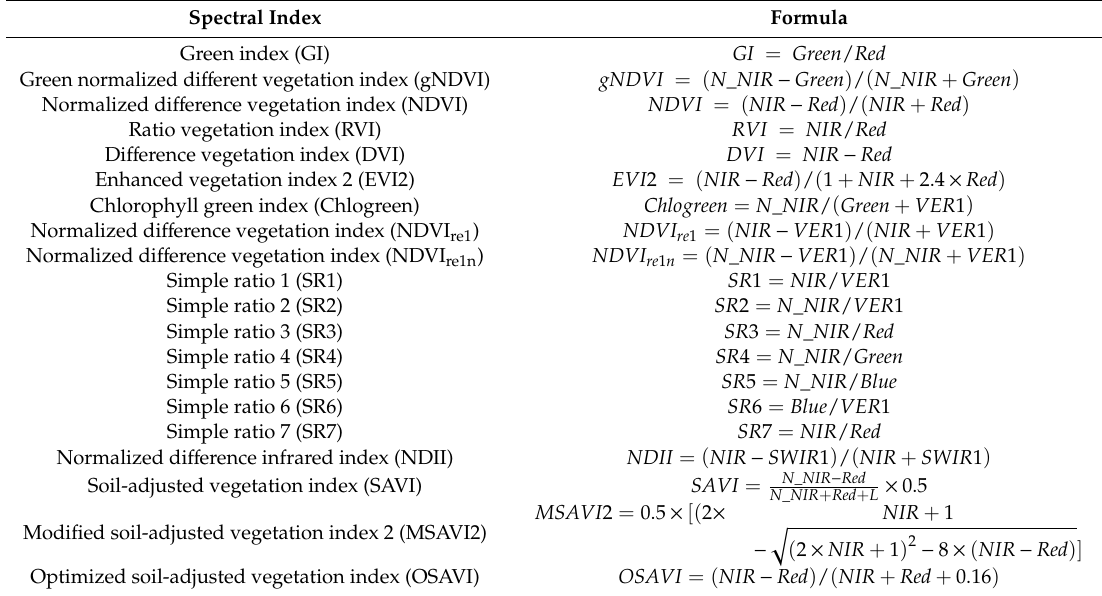
Table A1. Formulas used for calculating spectral indices [70].